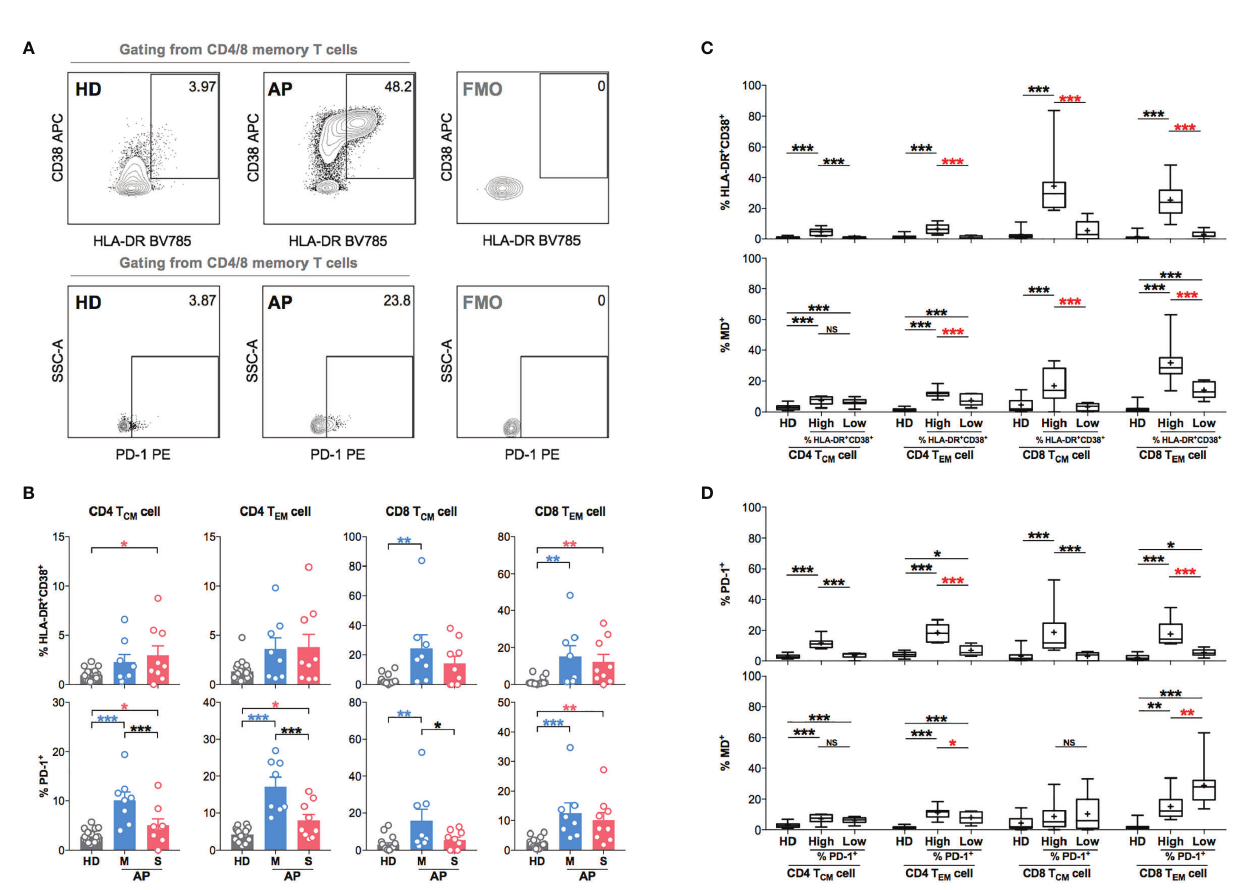
FIGURE 4 | Memory CD4 or CD8 T cells with increased level of T-cell hyperactivation exhibit higher MD + proportion at 11-15 days p.s.o. during SARS-CoV-2 infection. In order to understand the relationship between cells with mitochondrial dysfunction (MD + ) and T-cell activation in COVID-19 patients, 17 SARS-CoV-2 acute patients [APs; 8 mild (M) and 9 severe (S) ones on Day 11 – 15 p.s.o.] and 18 healthy donors (HDs) were collected for FACS analysis in at least three independent experiments. (A) Representative plots showed the gating strategy on HLA-DR + CD38 + and PD-1 + cells among central memory (CM) or effector memory (EM) subsets in CD4 or CD8 T cells. (B) The percentages of HLA-DR + CD38 + and PD-1 + cells in CD4 T CM , CD4 T EM , CD8 T CM , and CD8 T EM cells from mild and severe APs on Day 11 – 15 p.s.o. were displayed in bar charts. HDs served as control. (C) To investigate the relationship between MD + proportion and T-cell activation, the percentages of HLA-DR + CD38 + cells and MD + proportion in CD4 T CM , CD4 T EM , CD8 T CM , and CD8 T EM cells were compared between patients with a high percentage of HLA-DR + CD38 + cells (higher than median) and those with a low percentage of HLA-DR + CD38 + cells (not higher than median). (D) Similarly, the percentages of PD-1 + cells and MD + proportion in CD4 T CM , CD4 T EM , CD8 T CM , and CD8 T EM cells were compared between patients with high percentage of PD- 1 + cells (higher than median) and those with low percentage of PD-1 + cells (not higher than median). HDs served as control. Data represent mean ± SEM. Statistics were calculated based on one-way ANOVA test. * p < 0.05, ** p < 0.01, *** p < 0.001. NS, not signi fi cantly